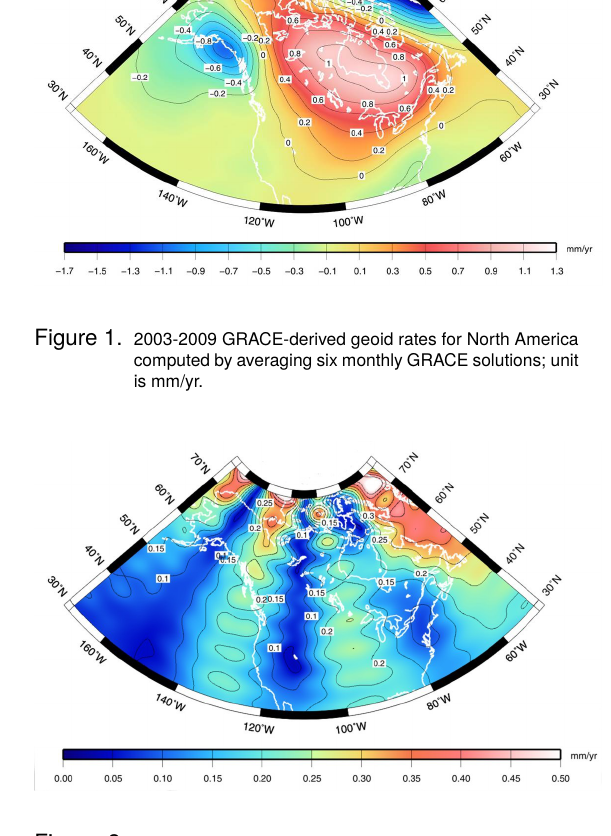
Figure 2. Standard deviations of the GRACE-derived geoid rates computed from the differences of the six solutions and the average rates in Fig. 1; unit is mm/yr.